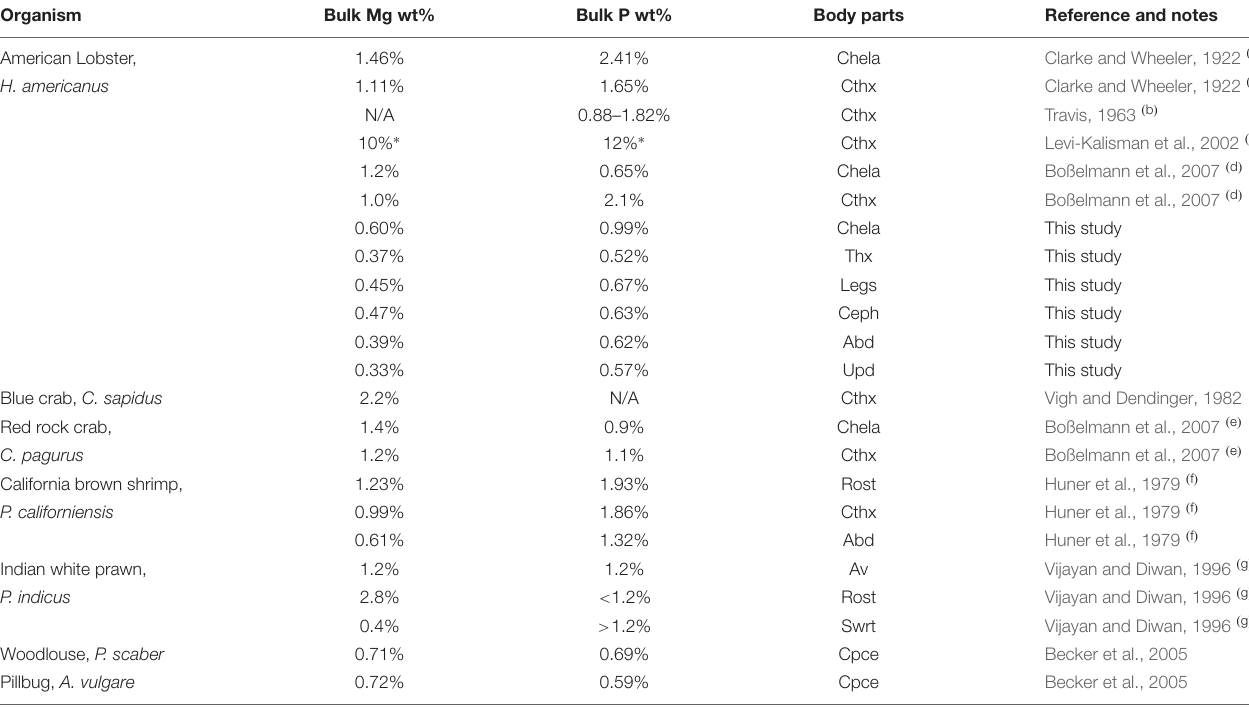
TABLE 1 | Summary of studies reporting the P and Mg content of the American lobster and other decapod exoskeletons.